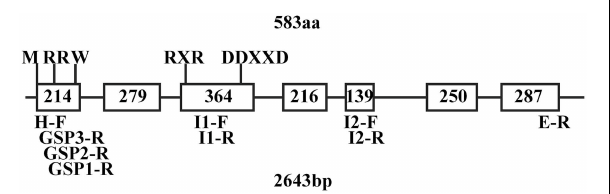
FIGURE 1 | QH6 gene structure showing sites and sizes of exons and introns, predicted conserved domains, and positions of designed primers. M, methionine as a translation start signal; RR(X) 8 W, conserved tandem arginine as a transit peptide signal (R 48 R 49 ), and a conserved tryptone (W 58 ) at the 9th residue after RR. The conserved RXR domain (R 300 D 301 R 302 ) used to direct the diphosphate anion away from the reactive carbocation after ionization and the DDXXD (D 337 D 338 V 339 Y 340 D 341 ) domain for divalent